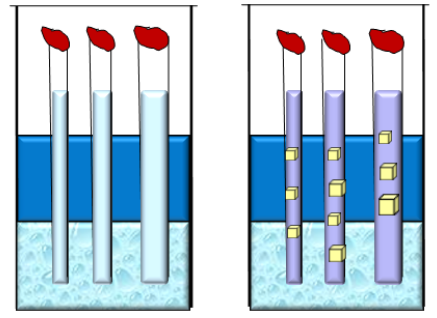
Figure 8. Counter diffusion–acupuncture method. Capillaries of different diameters filled with protein solution are placed in a gelled matrix, which is then overlayered with the precipitating solution. With time, diffusion of precipitant solution through the gel to the protein solution